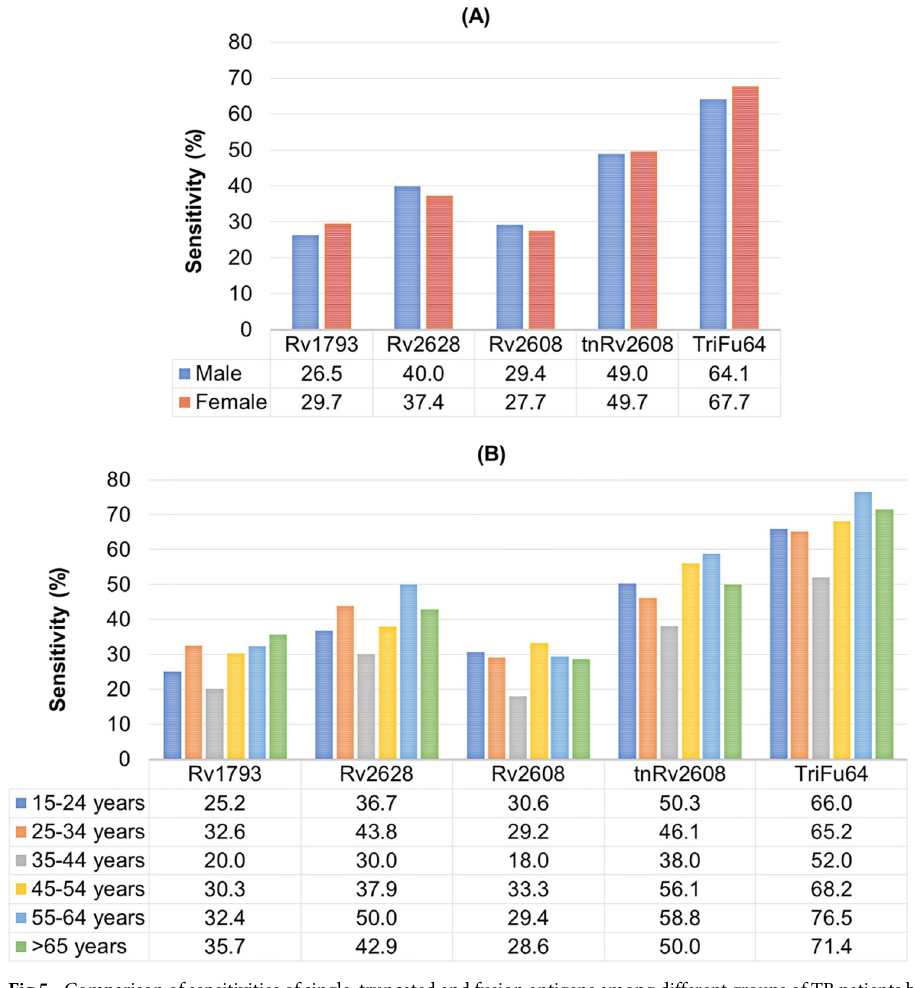
PLOS ONE | https://doi.org/10.1371/journal.pone.0258389 November12,